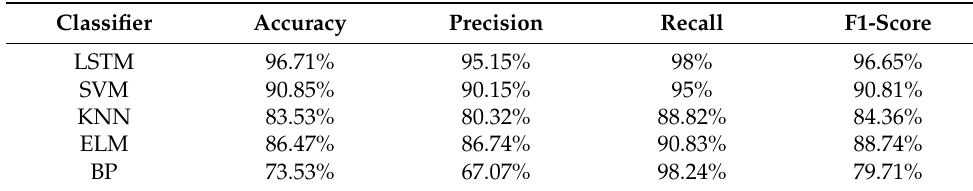
Table 8. Performance evaluation of different